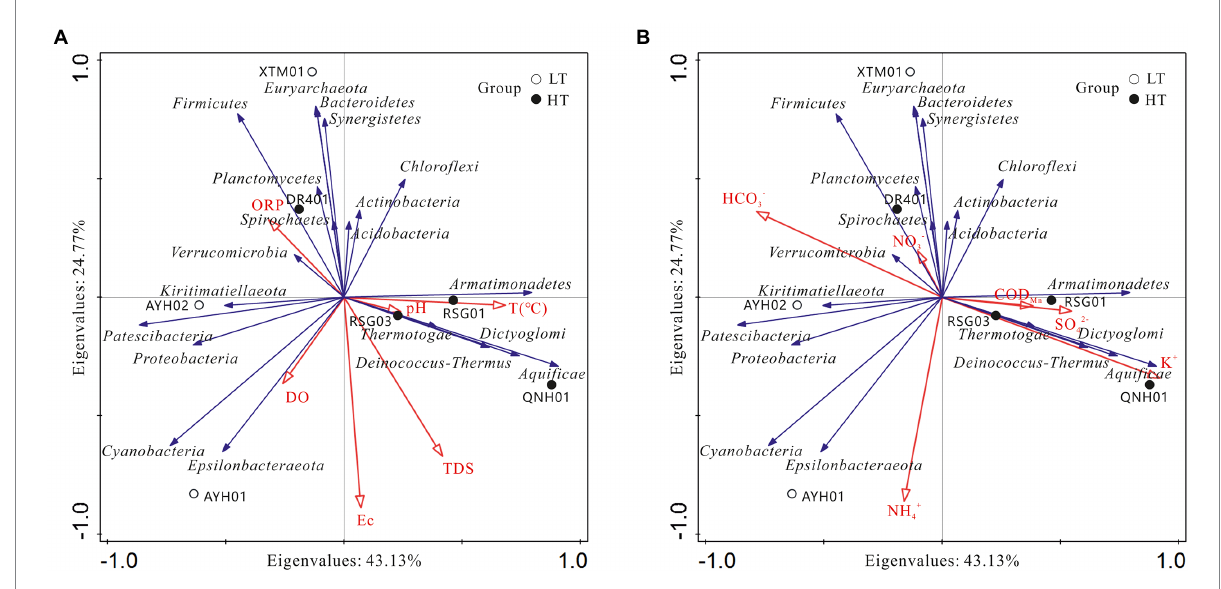
FIGURE 7 Analysis of relationships among samples, influencing factors ， and bacterial phyla. (A) Hydrological factor; (B) hydrochemical